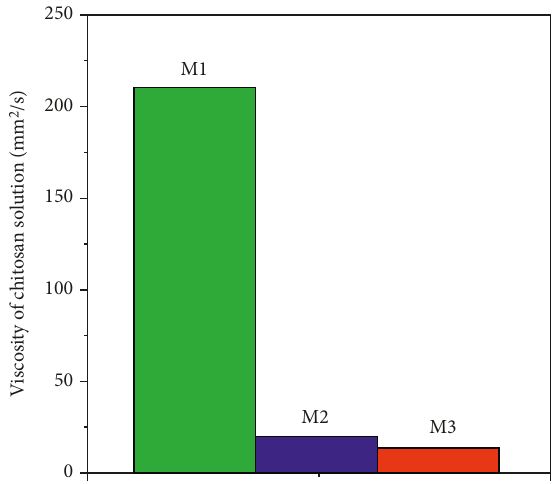
Figure 6: The viscosity value of 1.0 wt.% chitosan concentration in 90 wt.% acetic acid